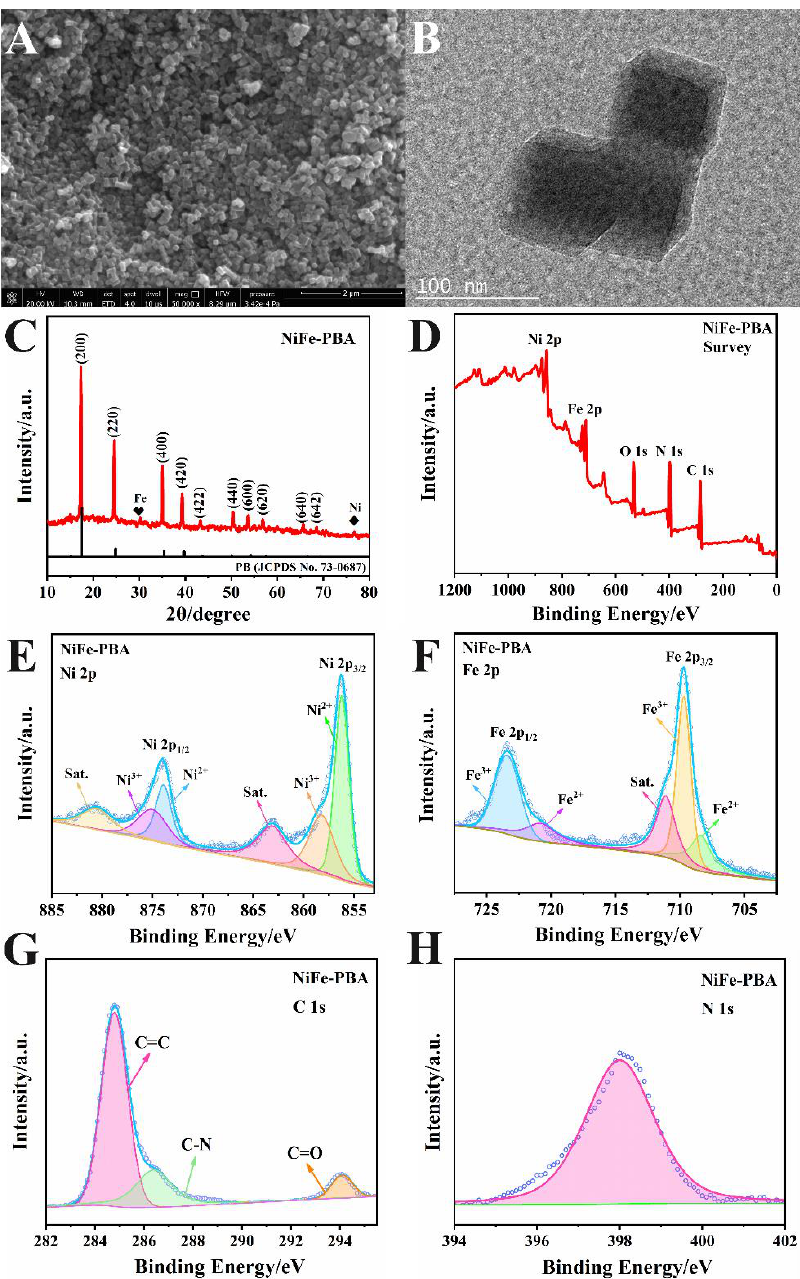
Figure 1. ( A ) SEM image, ( B ) TEM image, and ( C ) XRD image of NiFe-PBA. XPS spectra of NiFe-PBA: ( D ) full spectrum of XPS detection of NiFe-PBA; ( E ) Ni 2p spectrum, ( F ) Fe 2p spectrum, ( G ) C 1s spectrum, and ( H ) N 1s spectrum from the XPS detection of NiFe-PBA.